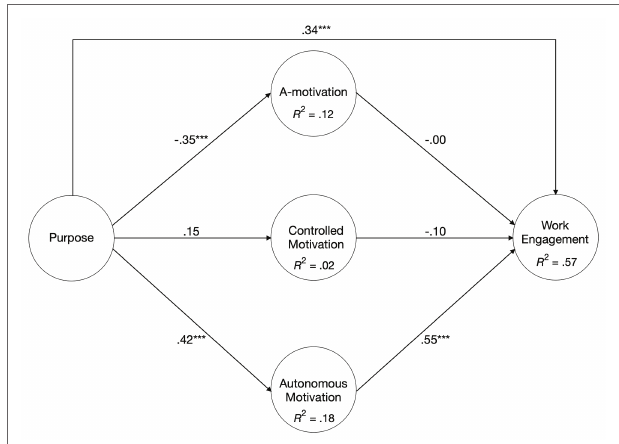
FIGURE 3 | Standardized path coefficients from purpose to work engagement via amotivation, controlled motivation, and autonomous